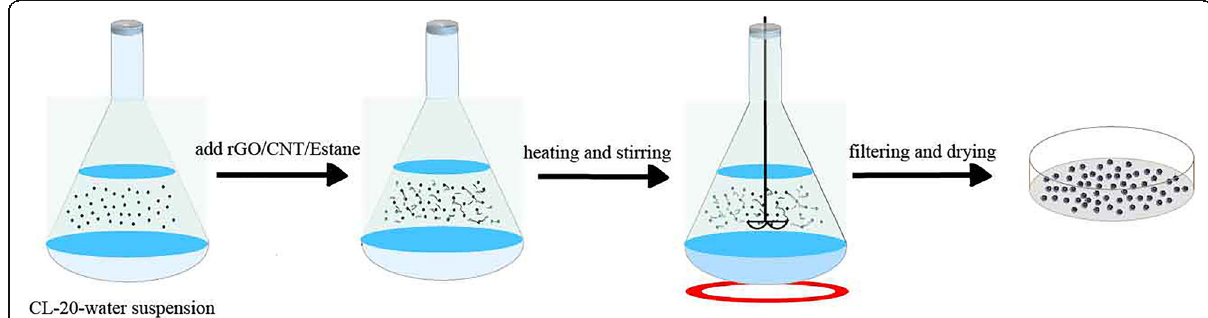
Fig. 1 Experimental diagram of CL-20-based composites prepared by water suspension